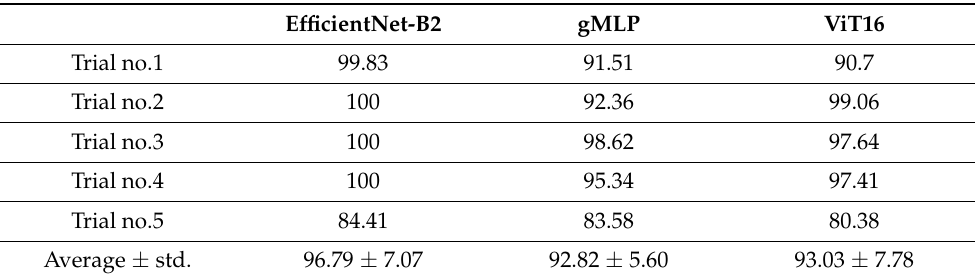
Table 5. Comparing the accuracy of EfficientNet-B2 in classifying COVID-19 class images with the accuracies of gMLP and ViT16.